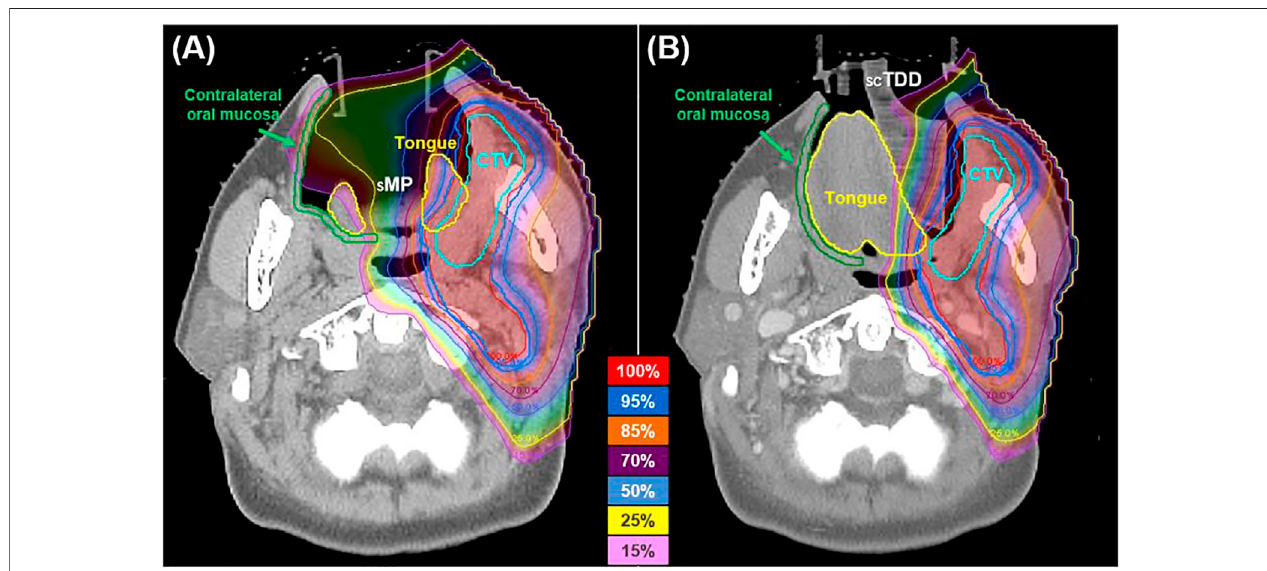
FIGURE 3 | Axial dose distributions of the S MP (A) and SC TDD (B) in a patient with oral cavity cancer. The SC TDD acted as a proton beam stopper to protect the contralateral oral mucosa (green).